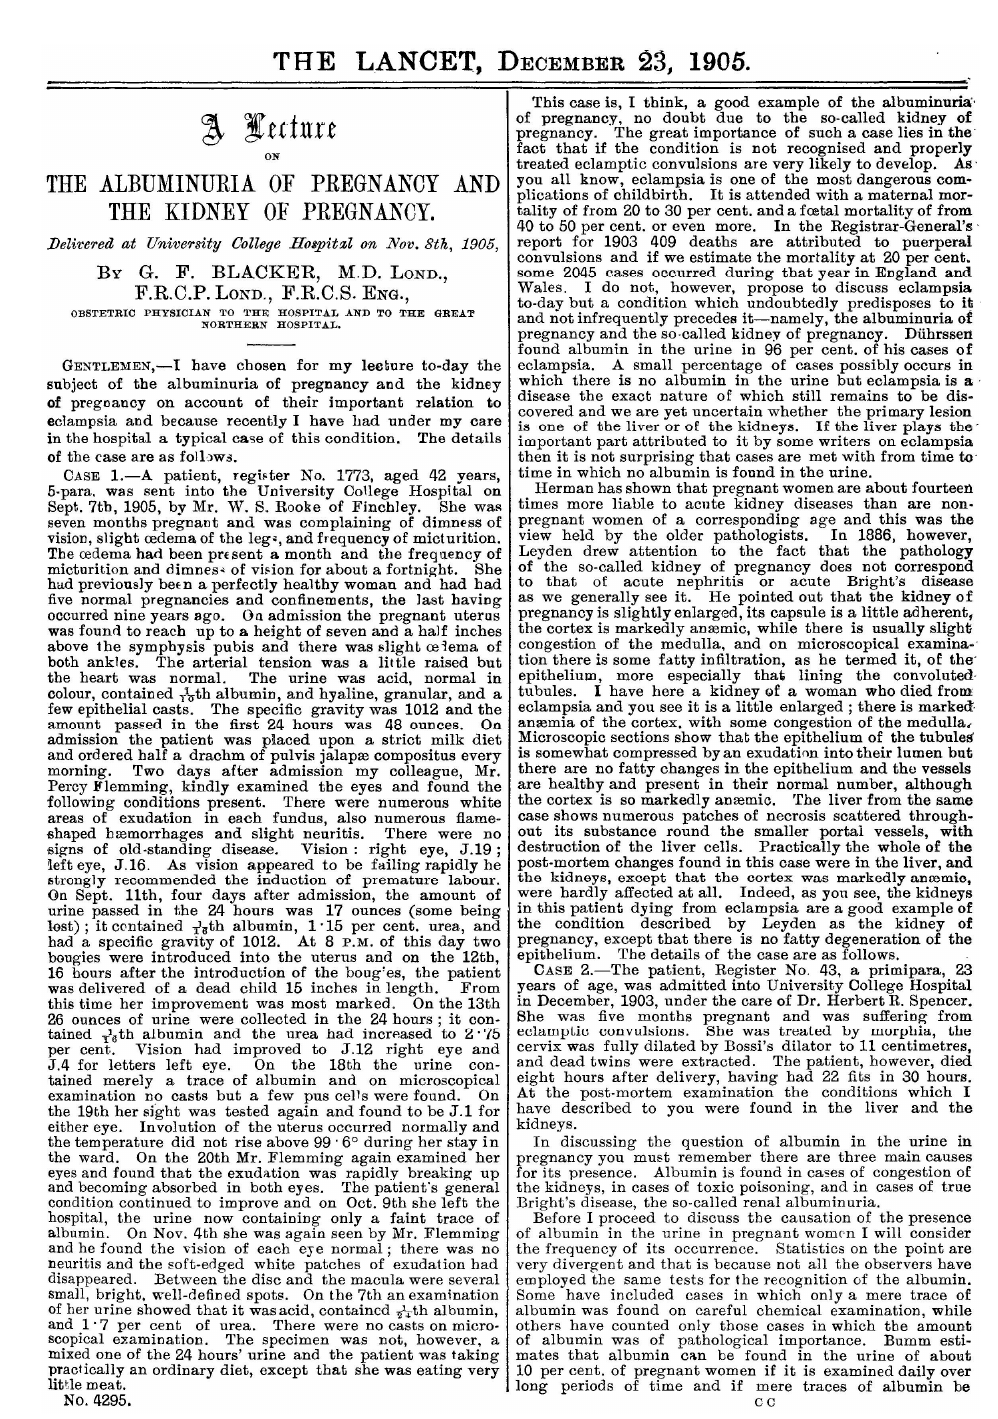
Figure 2. The front page of the paper “The albuminuria of pregnancy and the kidney of pregnancy”, The Lancet , December 23, 1905.